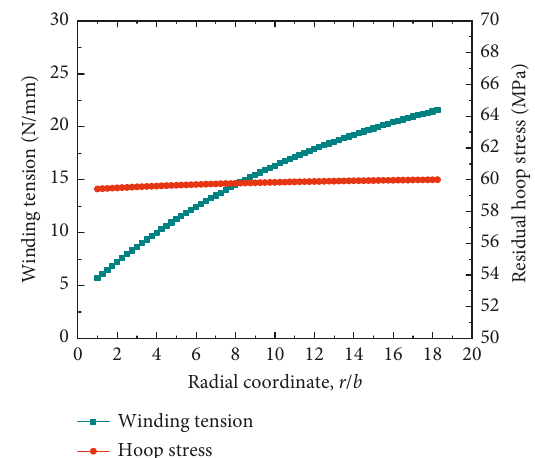
Figure 9: Designed winding tension and the corresponding re- sidual hoop